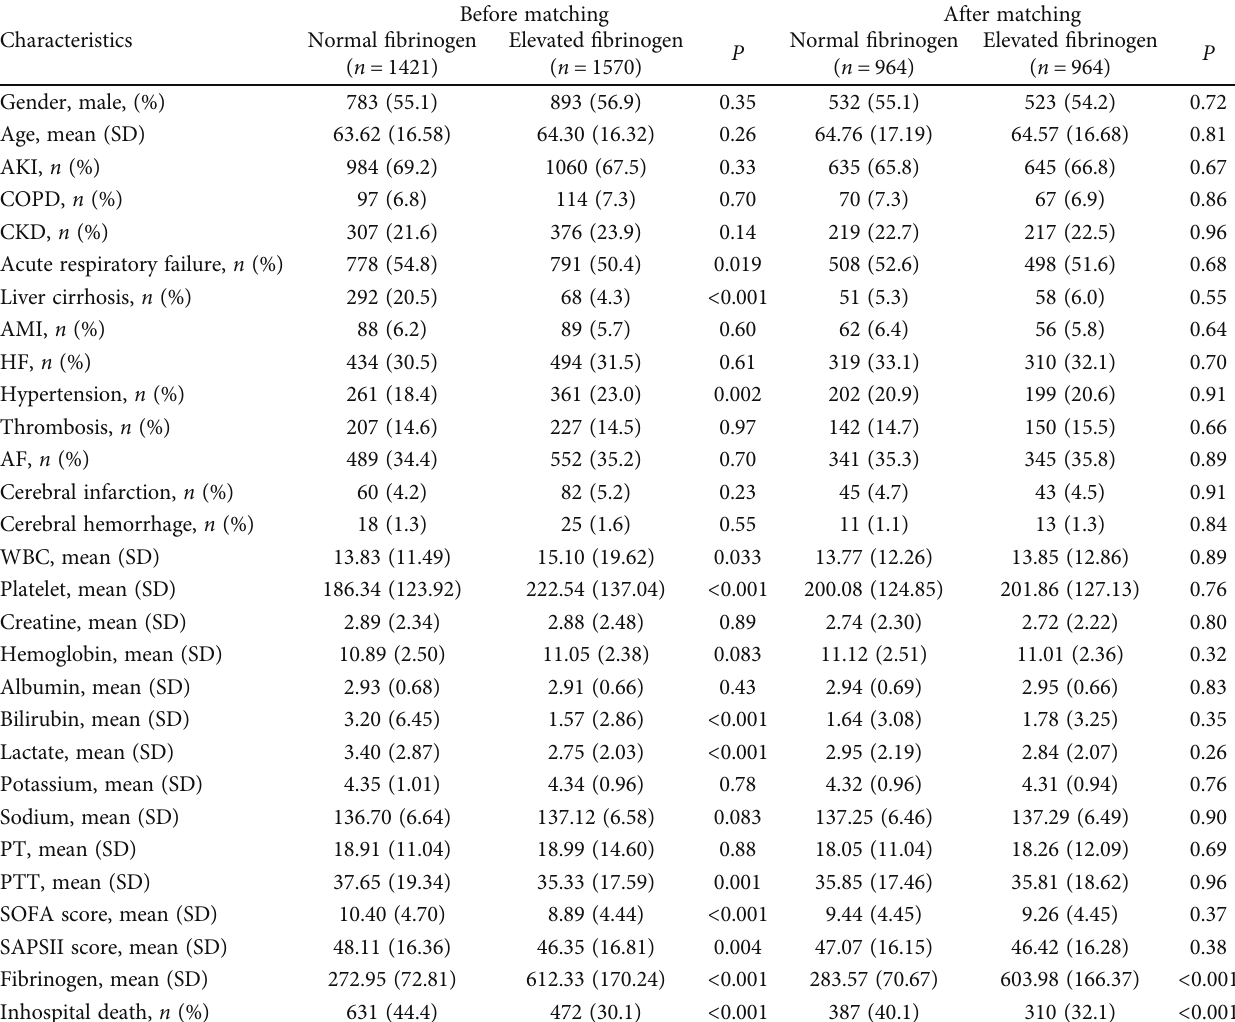
Table 3: Baseline characteristics of normal fi brinogen and elevated fi brinogen group before and after matching.